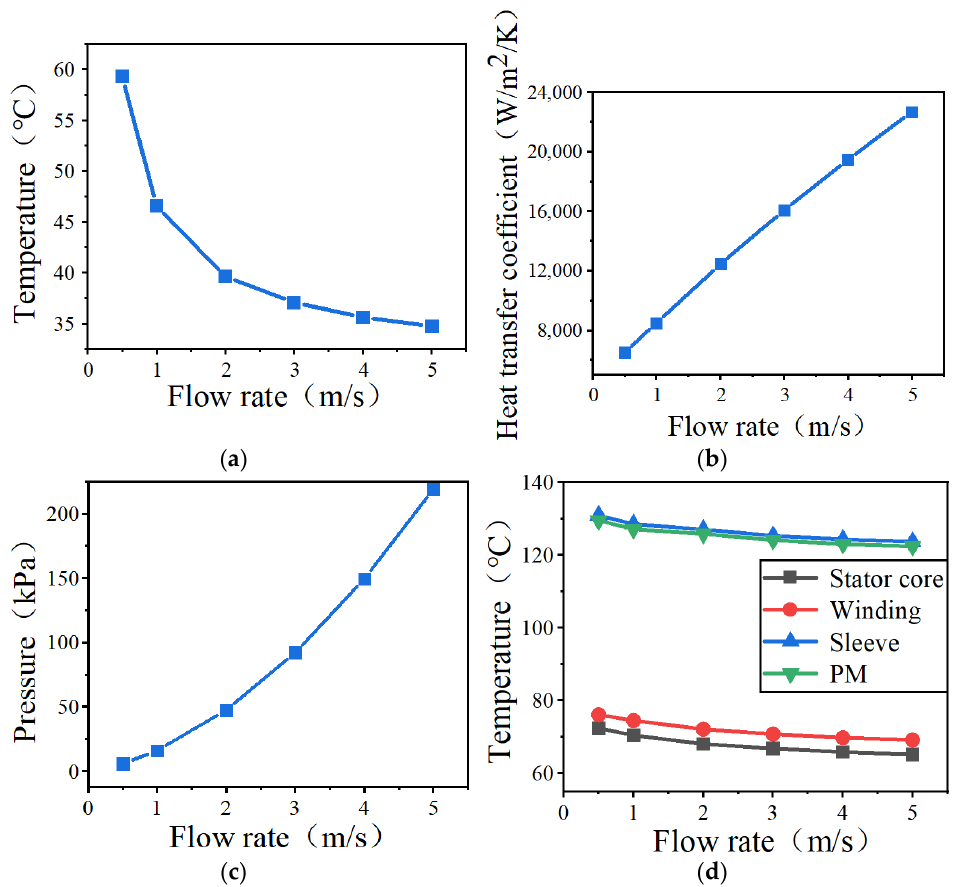
Figure 16. Thermal analysis results of HSPMMs at different cooling water flow rates. ( a ) Cooling water maximum temperature; ( b ) heat transfer coefficient; ( c ) inlet pressure; ( d ) motor maximum temperature.